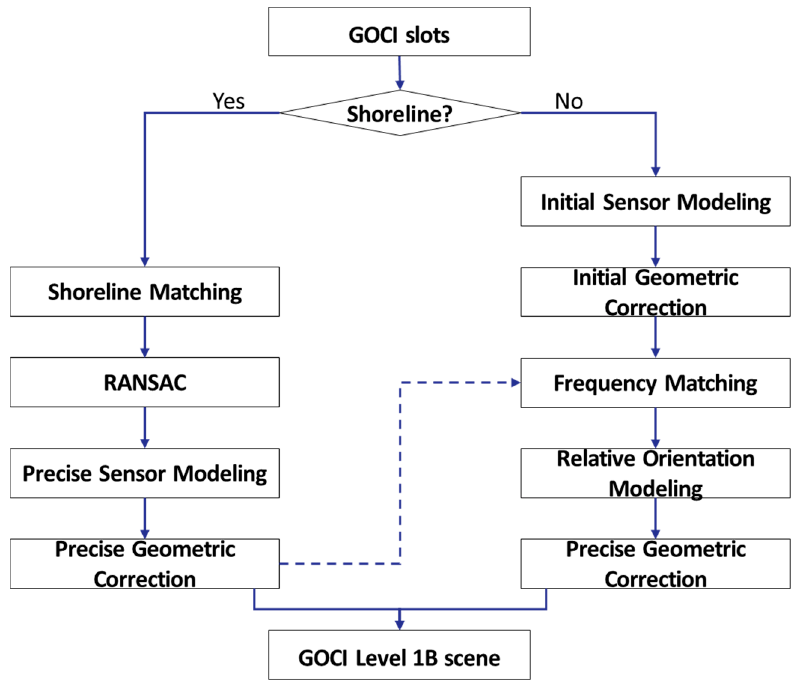
Figure 2. Process of the proposed method.